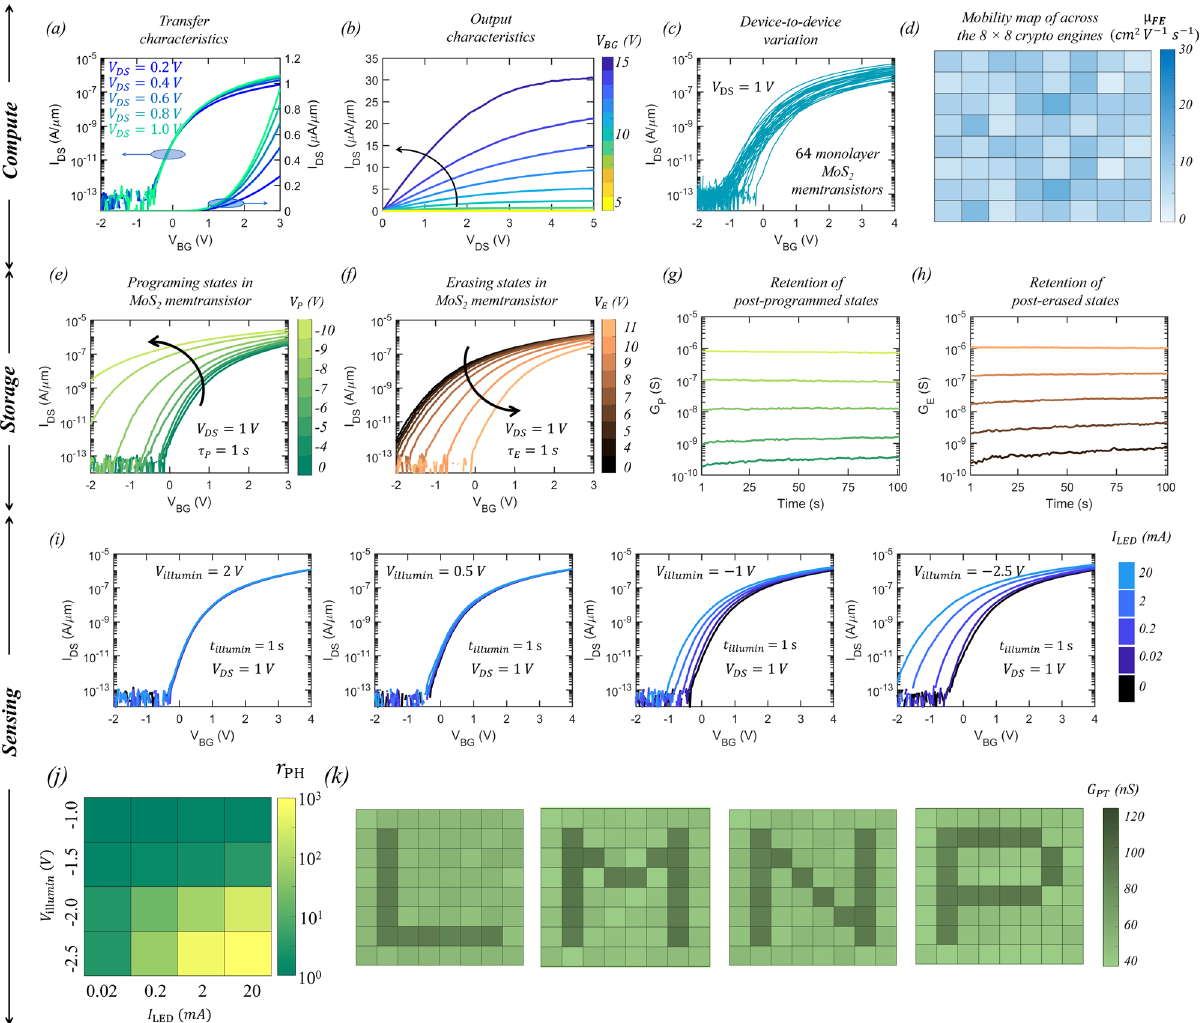
Fig. 2 MoS 2 memtransistor for compute, storage, and sensing. a Transfer characteristics, i.e., source to drain current ( I DS ) versus back-gate voltage ( V BG ) at different drain biases ( V DS ), and ( b ) output characteristics, i.e., I DS versus V DS for different V BG , of a representative MoS 2 memtransistor. c